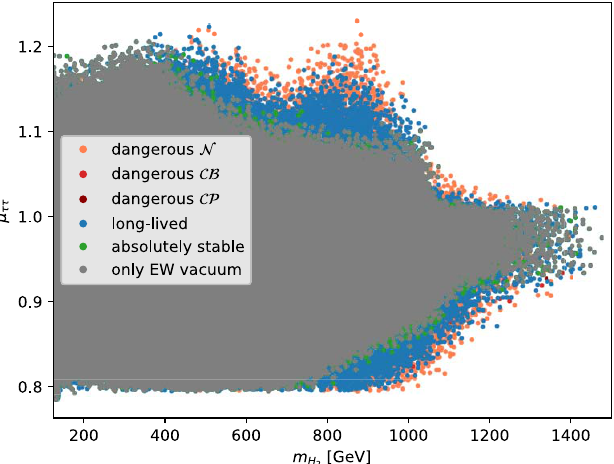
Figure 5 . The signal strength µ of h 125 ττ as a function of the second lightest neutral ττ → . The parameter points without any secondary minima (grey) are plotted on top, scalar mass m H 2 followed by the absolutely stable (green), and long-lived (blue) parameter points. Below these, the points with dangerous secondary minima are shown in different shades of red denoting the type of dangerous minimum present ( — light red, — red, — dark N CB CP